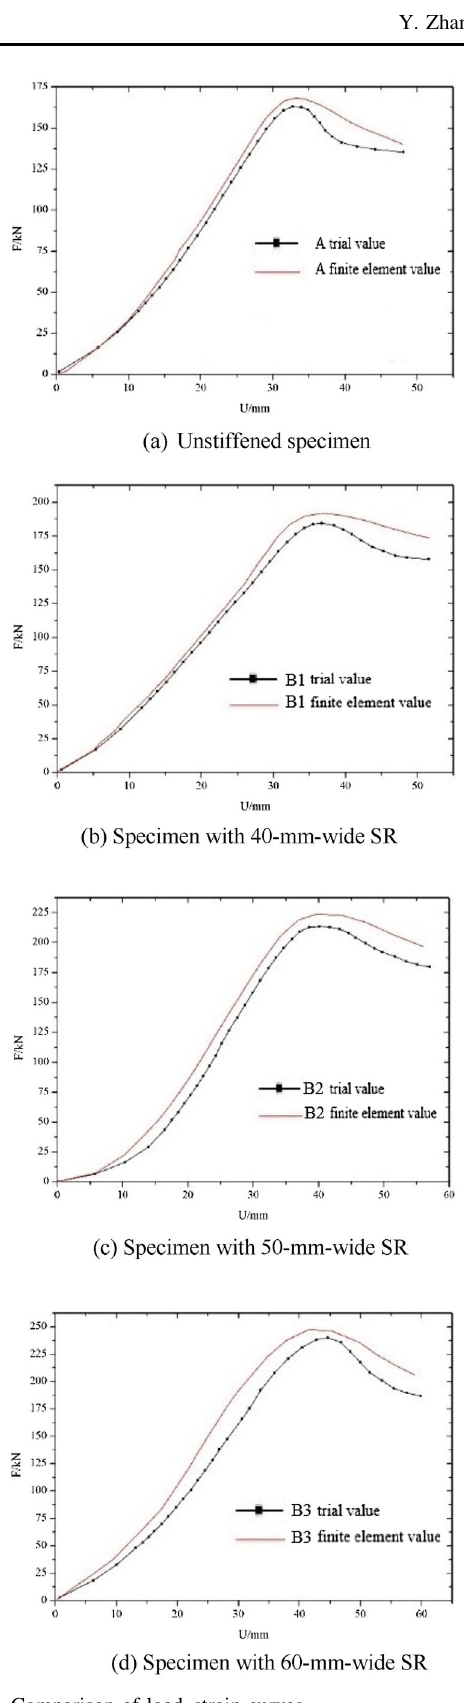
Fig. 17 Comparison of load–strain